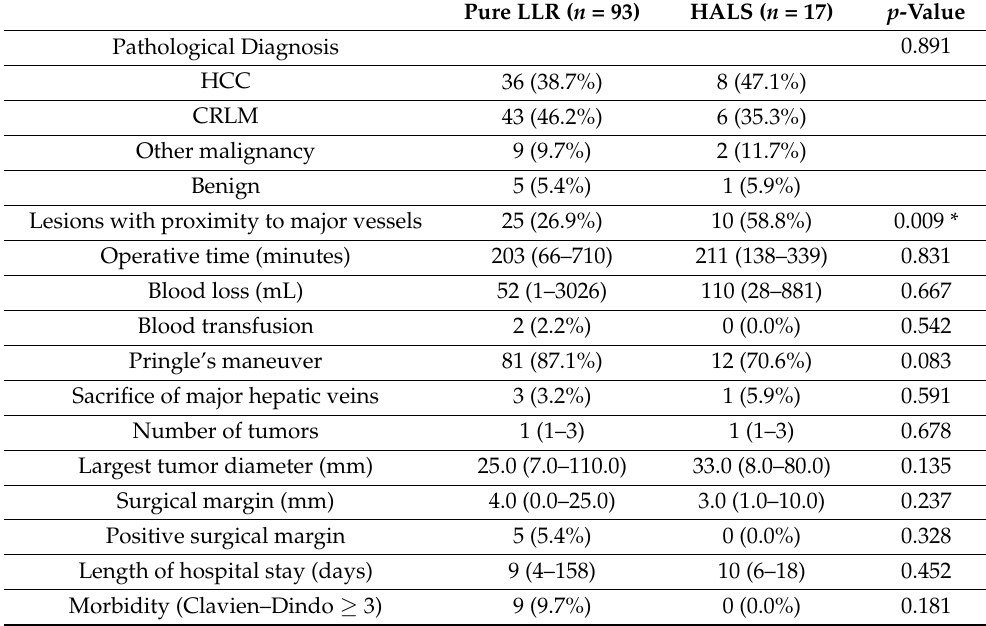
Table 6. Surgical outcomes of pure LLR and